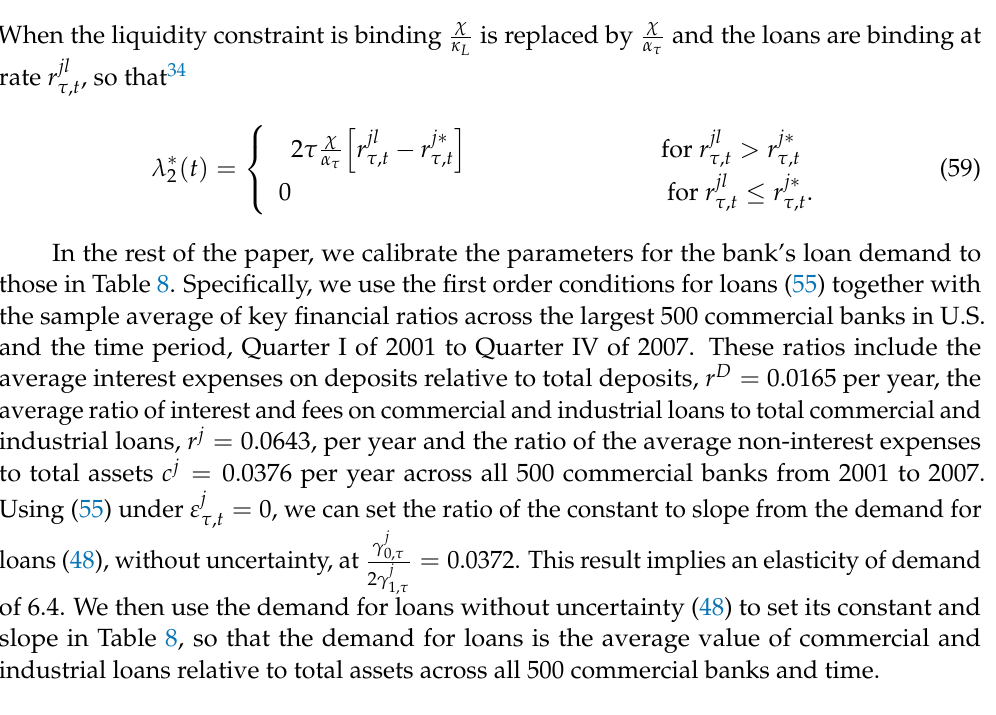
Table 8. Parameters for Loan Demand (48) and